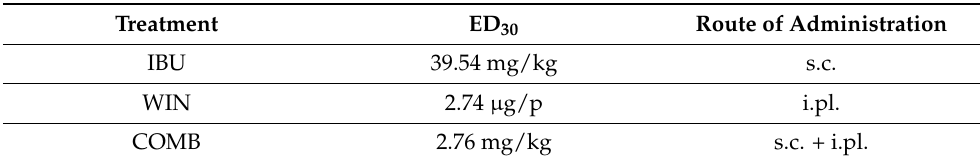
Table 1. The effective dose 30 (ED 30 ) of the drugs in the study, each administered through the corresponding